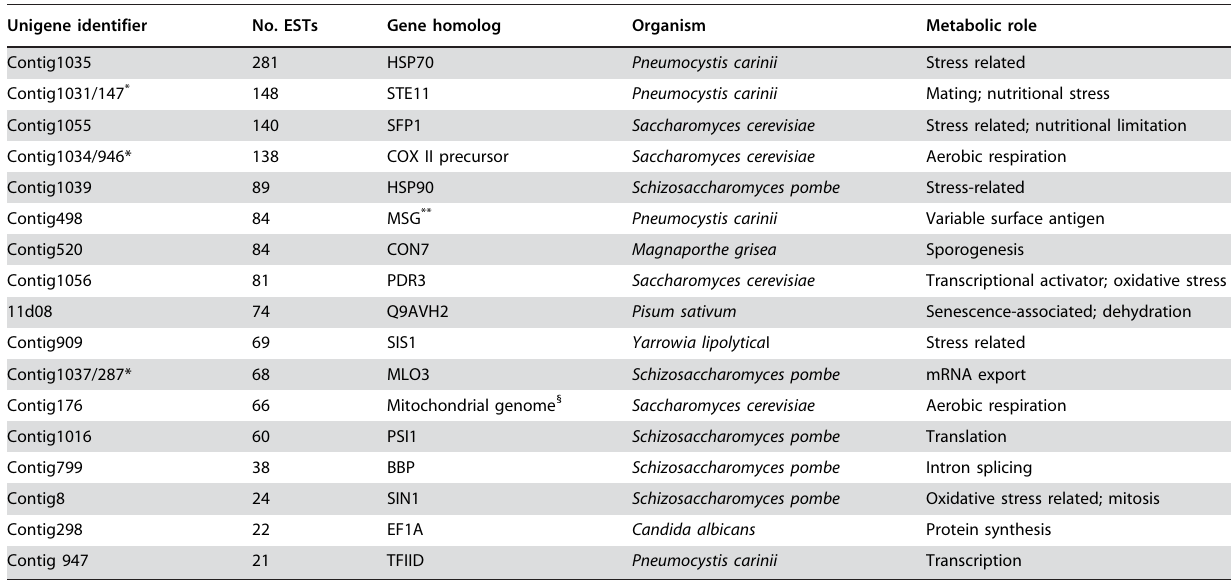
Figure 2. Most of the sequences shared similarities with known